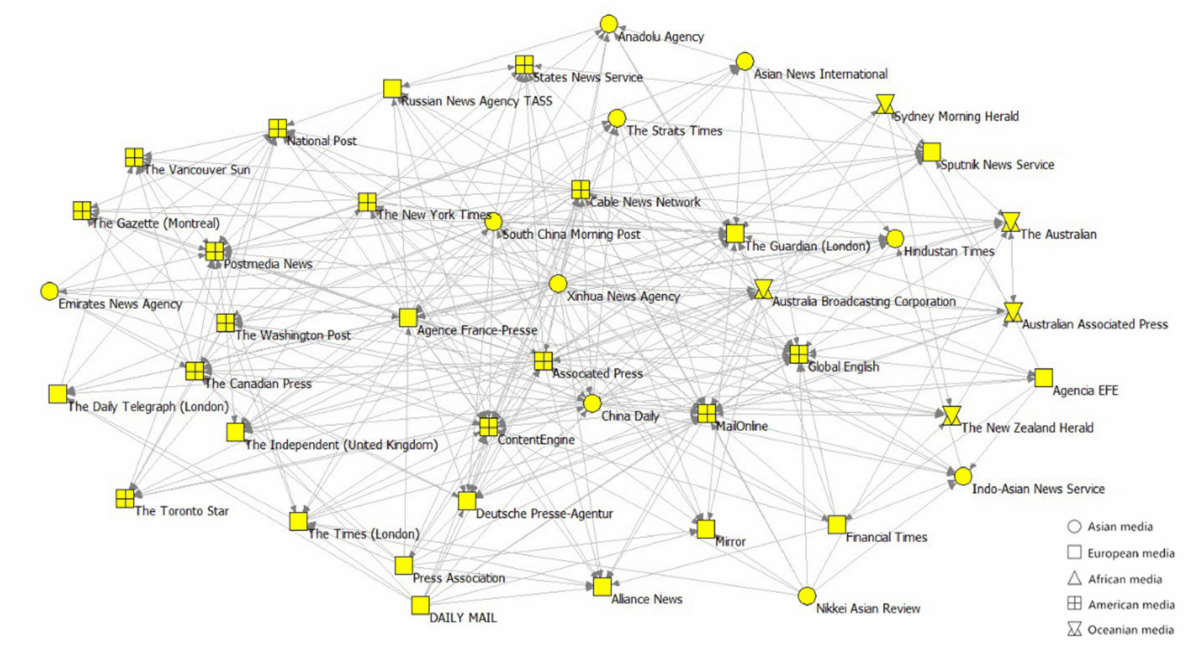
Figure 6. The core of Network-S1.